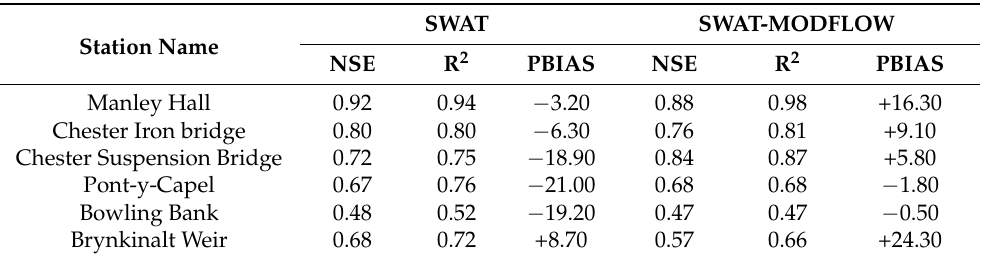
Table 3. Performance statistics of the standalone SWAT model and the coupled SWAT-MODFLOW model for the calibration period of 1995–2000 for streamflow.